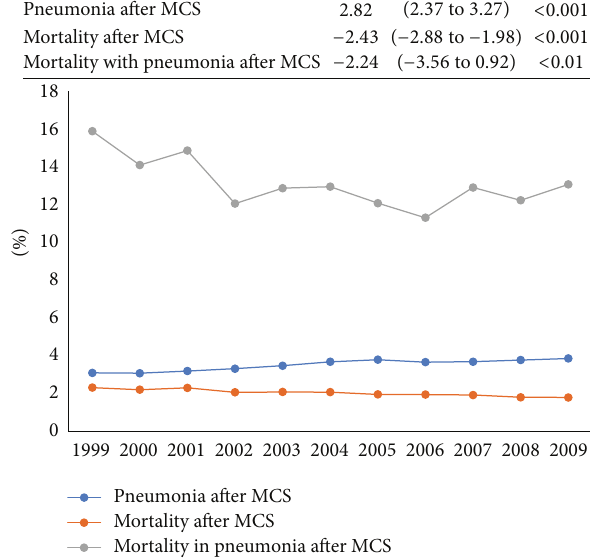
Figure 1: Pneumonia and mortality with pneumonia in major cancer surgery (MCS) patients between 1999 and 2009 in the United States. EAPC: estimated annual percentage change and CI: confidence